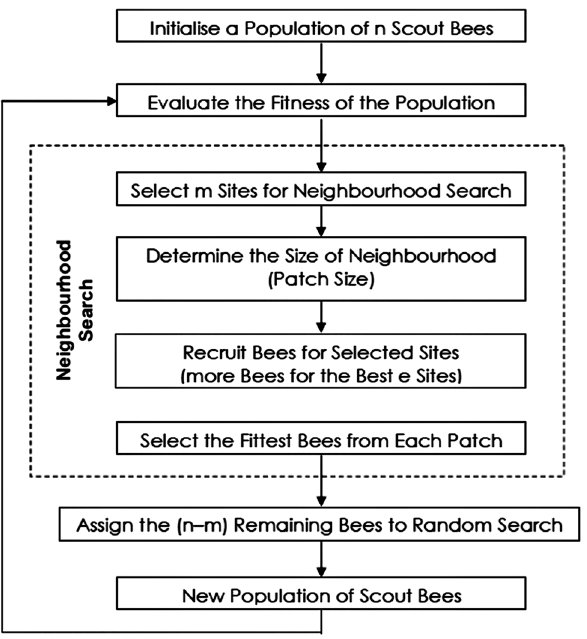
Figure 1: Flowchart of a basic Bees algorithm.